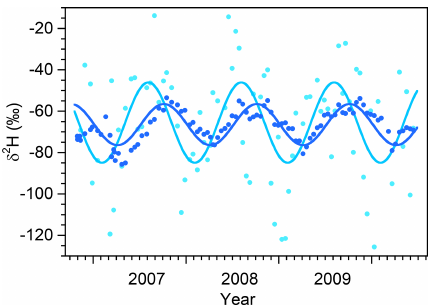
Figure 9. Deuterium time series in biweekly bulk samples of pre- cipitation (light blue) and grab samples of streamwater (dark blue), with superimposed seasonal sinusoidal cycles fitted by volume- weighted least squares. The vertical axis has been expanded to bet- ter show the seasonal cycles, with the result that several precipita- tion values are not shown. The amplitudes of the fitted seasonal cy- cles are A P = 194 ± 34‰ and A S = 87 ± 09‰ in precipitation and streamflow, respectively, implying that the flow-weighted young water fraction (the fraction of discharge that is younger than ap- proximately 2–3 months) is F ∗ yw = A S /A P = 045 ± 009. Rescaling F ∗ yw by the ratio between the average annual discharge and pre- cipitation fluxes yields the flow-weighted young water fraction of precipitation (the fraction of precipitation that is discharged in less than approximately 2–3 months), P F ∗ yw = F ∗ yw Q/P = 0 . 29 ± 0 .